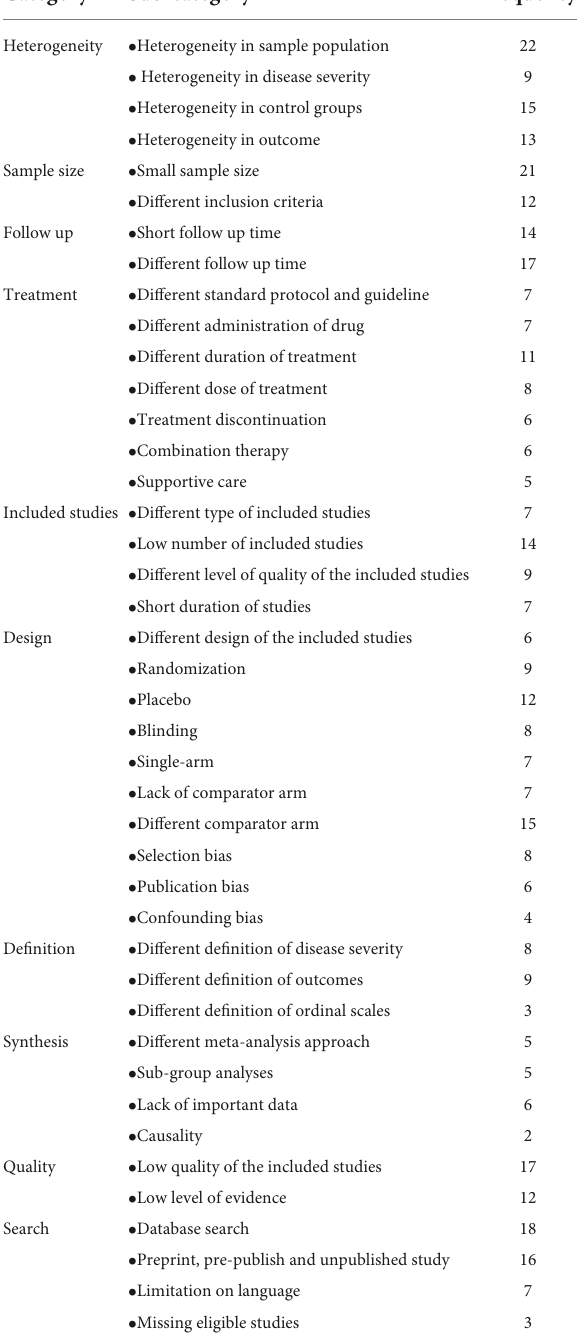
TABLE 2 Potential limitation of the included